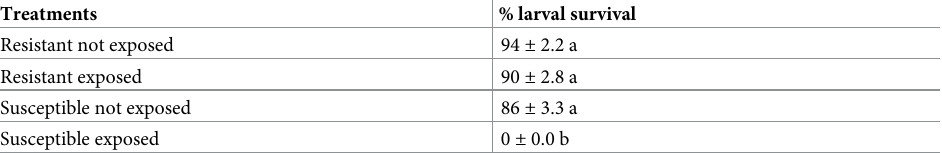
Table 1. Survival (±SE) of Spodoptera frugiperda exposed or not to Cry1F as larvae from ten days after eclosion until pupation ( n = 9). Resistant larvae were from Leite et al. [18] population and susceptible from SUS population described by Farias et al.